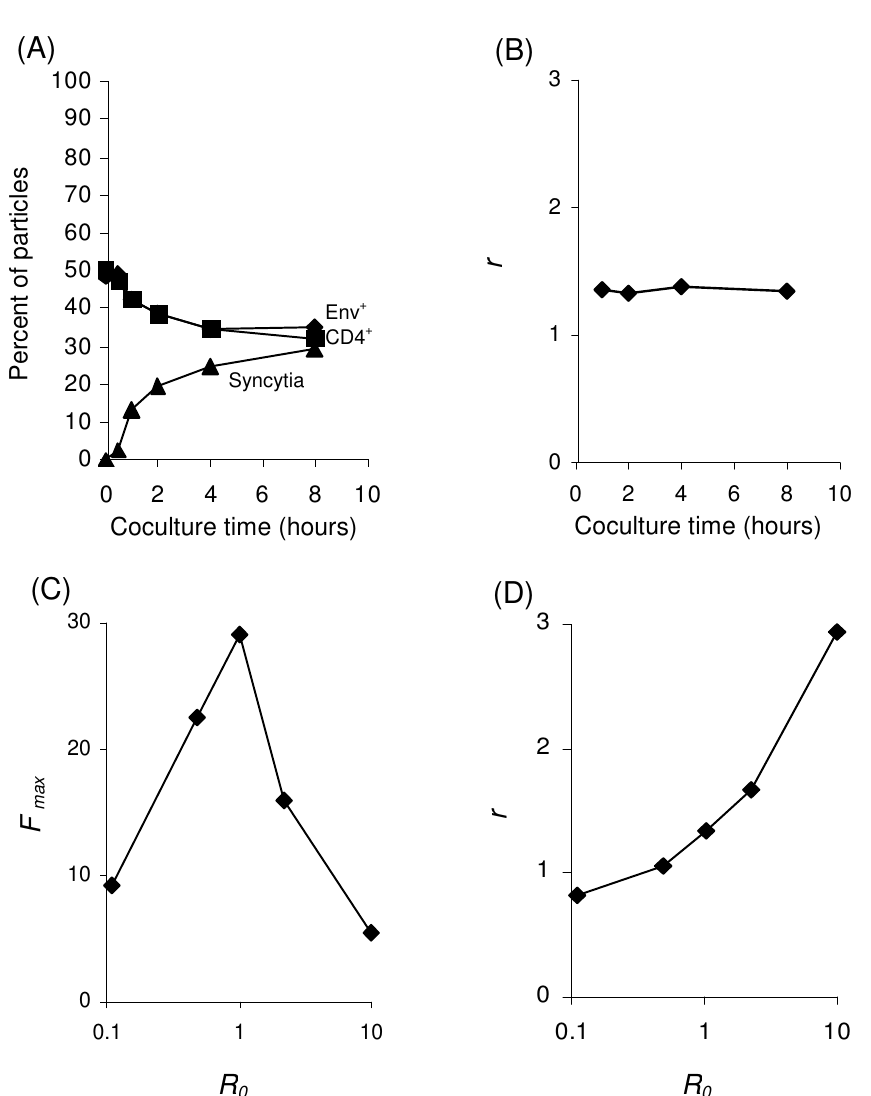
FIGURE 7 . Changes in the percentages of syncytia and unfused cells (A) and in the ratio r (CD4 + /Env + ) of incorporation of fusion partners into syncytia (B), at equal initial proportions of CD4 + and Env + fusion partners ( R 0 = 1). (C) Relationship of F max with R 0 and (D) relationship of r with R 0 . (Reprinted from Lopez-Balderas et al.[84]. Copyright 2007, with permission from